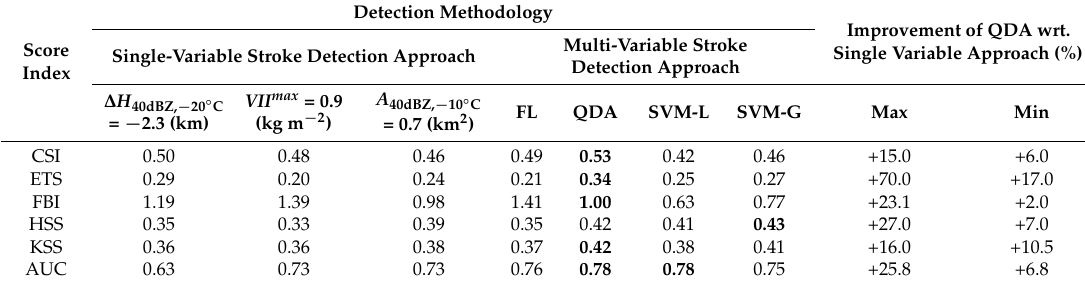
Table 6. Statistical scores indexes resulting from verification analysis using seven different